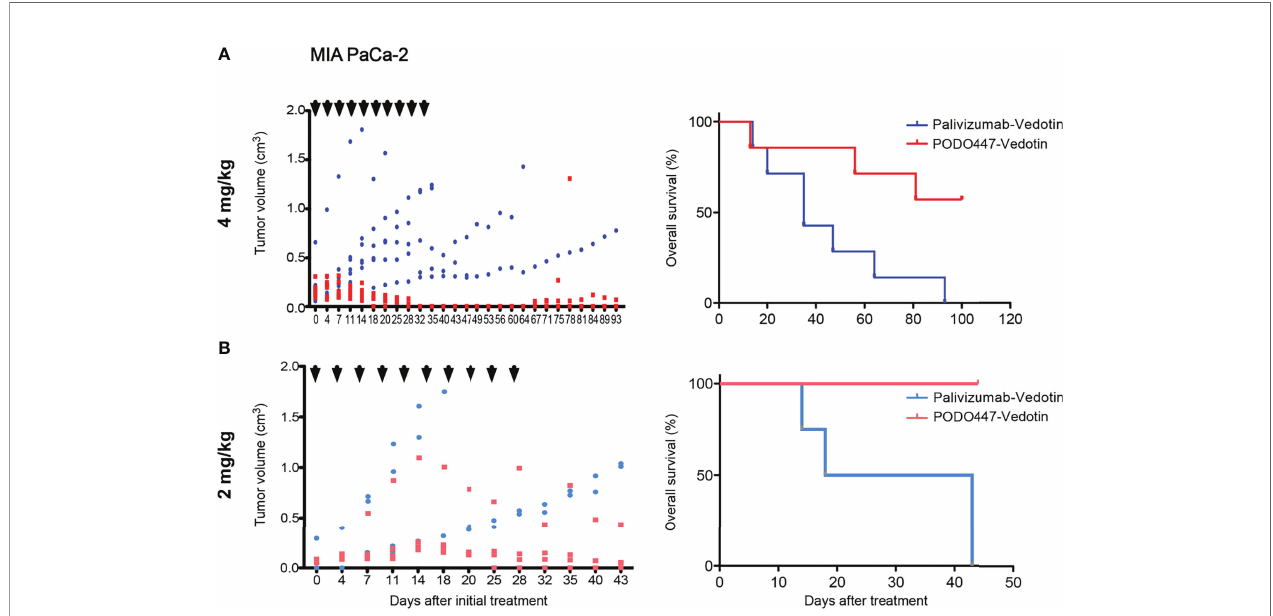
FIGURE 6 | PODO447 therapeutic effect on pancreatic tumor bearing Nude mice with intact B and NK cell activity. PODO447- and palivizumab-ADC therapeutic effect on MIA PaCa-2 tumor growth (left panel) and overall survival (right panel) of tumor-bearing nude mice. Mice were treated with ADCs at (A) 4 mg/kg/injection (left P < 0.01; right P < 0.05) and (B) 2mg/kg/injection (left ns; right P < 0.001) following the treatment schedule indicated by the arrowheads. Data in (A) is from two independent experiments with n = 3-4 mice per group. Data in (B) is from one experiment with n = 4 mice per